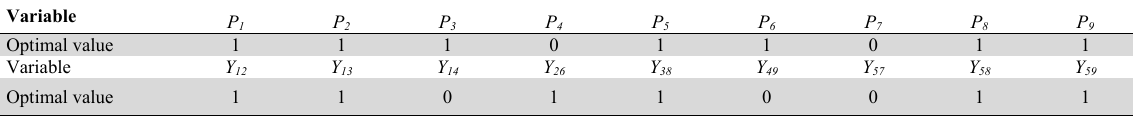
Optimal values of numerical example variables